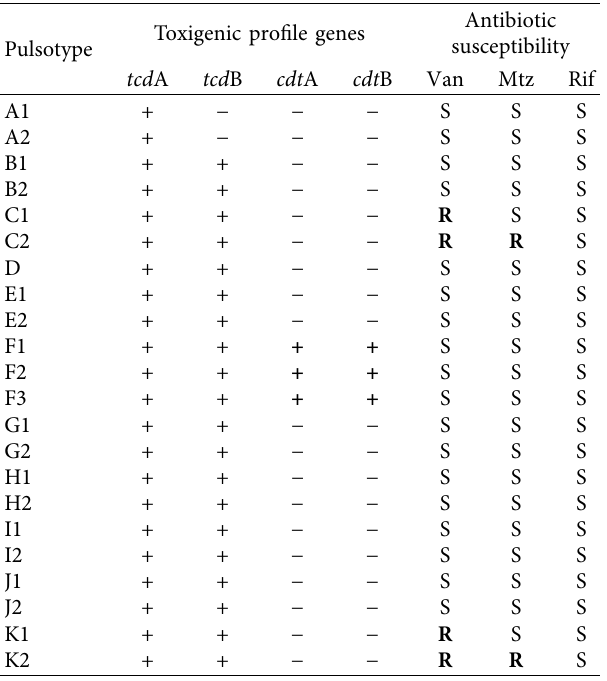
Table 3: Distribution of toxigenic profile of comparison isolates together with antibiotic